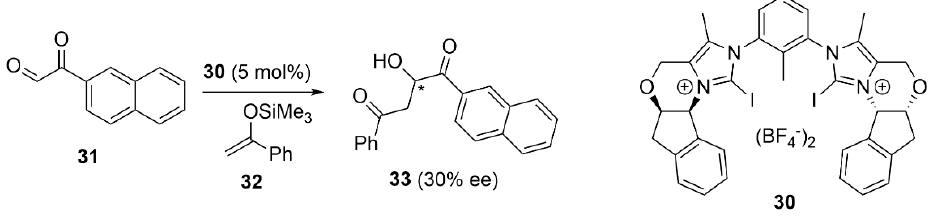
Figure 18. XB-Catalyzed asymmetric Mukaiyama reaction.